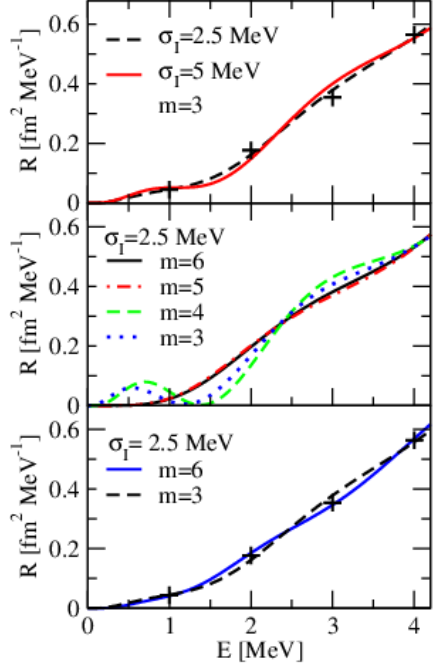
Figure 6: Upper panel: converged inversion results with σ equal to 5 (red solid) and I 2.5 MeV (dashed black); middle panel: Inversion results with N = 8 for basis sets = E m with different exponents m , namely m = 3,4,5,6 with threshold functions f thr = 2.5 MeV and (see Eqs. (7), (8)); lower panel: converged inversion results with σ I m = 3 (black dashed) and m = 6 (blue solid). Plus signs describe exact